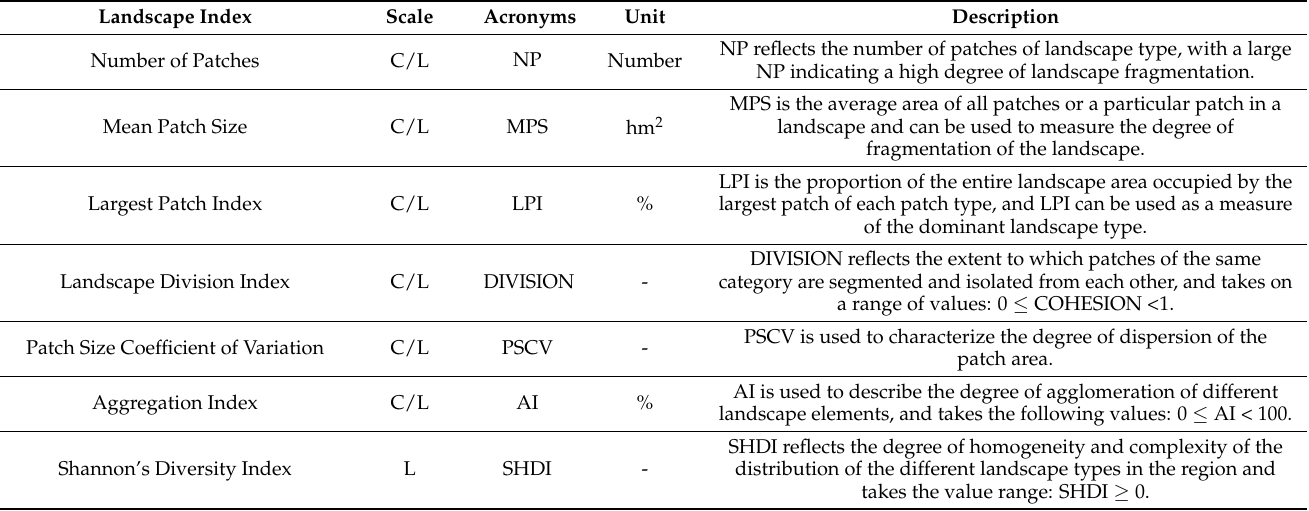
Table 4. Indices and their meaning for landscape